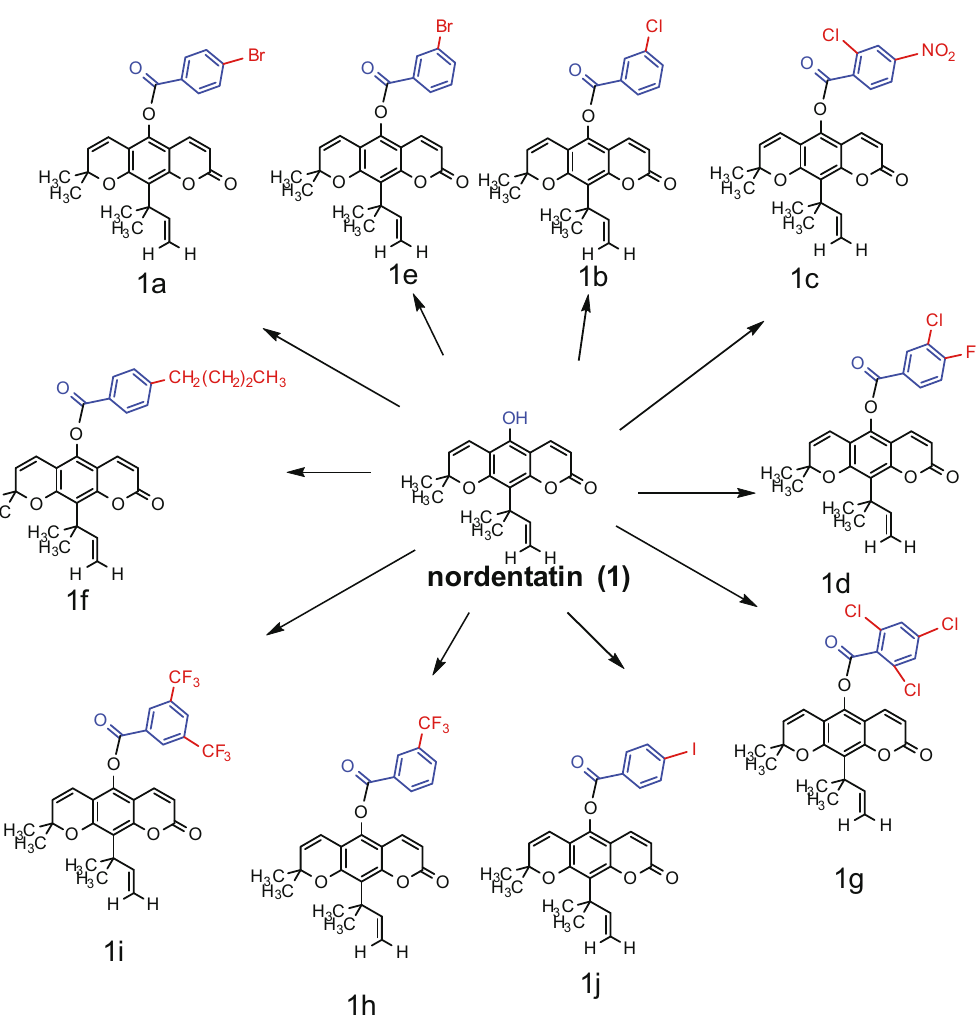
Figure 2: Structures of derivatives 1a – 1j from nordentatin ( 1 )